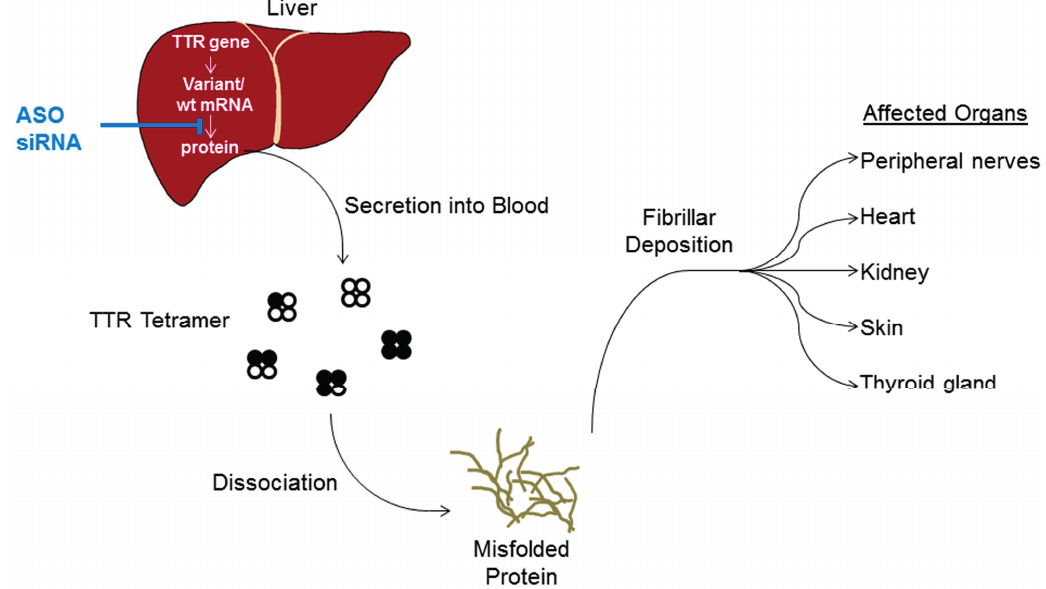
Figure 1. Schematic illustration of FAP amyloidosis. Wild-type and mutant TTR (open and closed circle, respectively) are secreted by the liver into blood as a tetrameric protein that is unstable when comprising mutant protein. Tetramers dissociate into monomers which misfold and aggregate. Deposition of TTR fibrils is observed in peripheral tissues and organs. In order to treat FAP, antisense oligonucleotides (ASO) and small-interfering RNAs (siRNA) that target TTR mRNA in the liver are currently evaluated in clinical